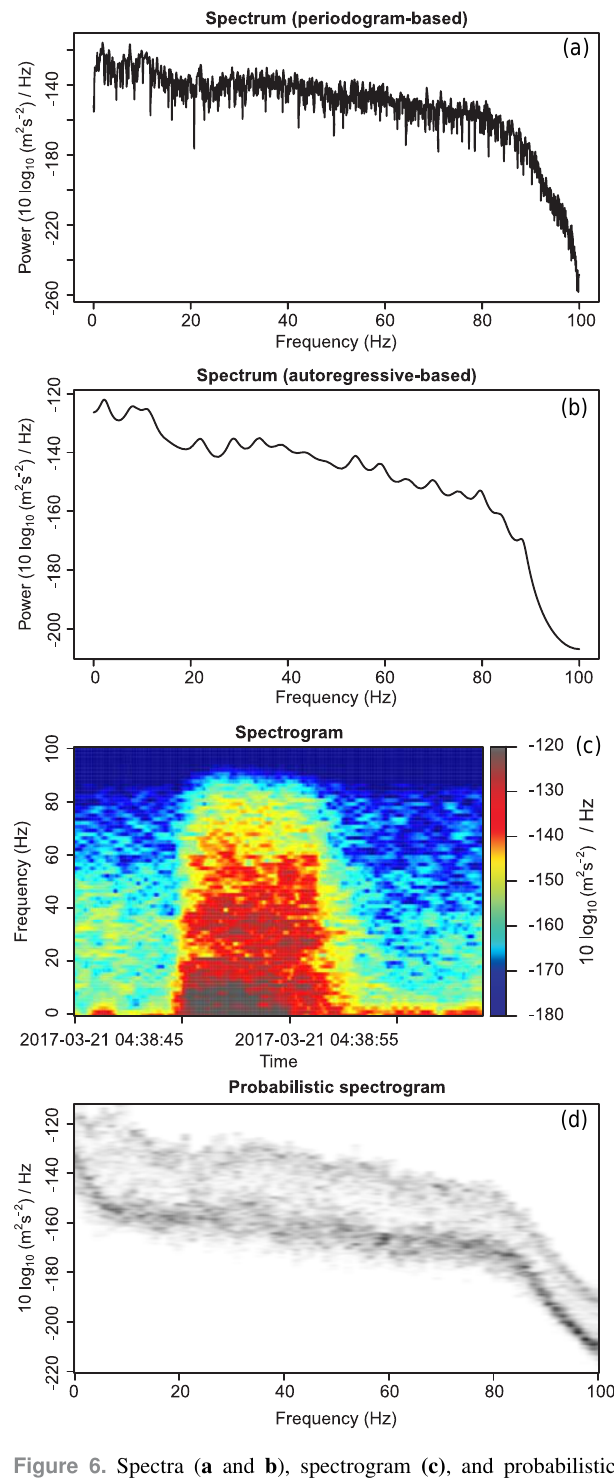
Figure 6. Spectra ( a and b ), spectrogram (c) , and probabilistic spectrogram (d) of the cliff collapse event depicted in Fig. 5 at sta- tion